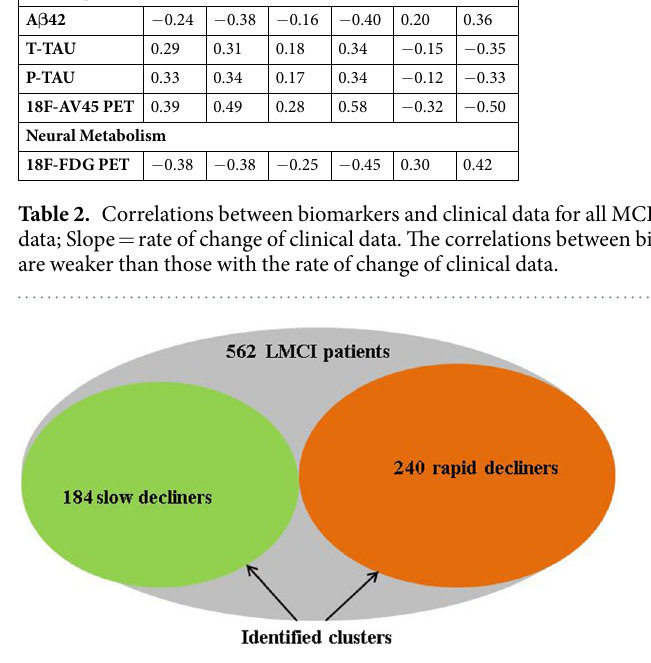
Figure 2. Clustering of the total (N = 562) MCI sample into Rapid and Slow